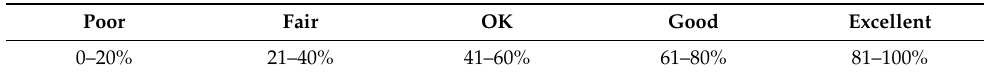
Table 1. Five-point AIRP-ENV Presence Rating